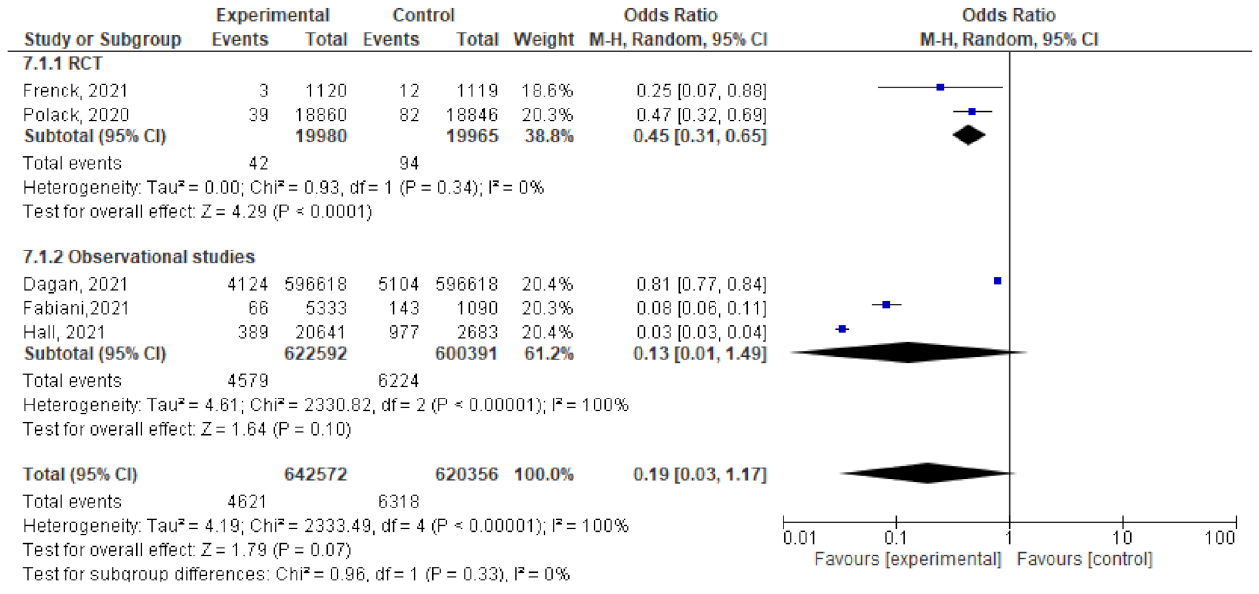
Figure 7. Incidence of SARS-CoV-2 infection either symptomatic or asymptomatic within 21 days after the 1st dose of